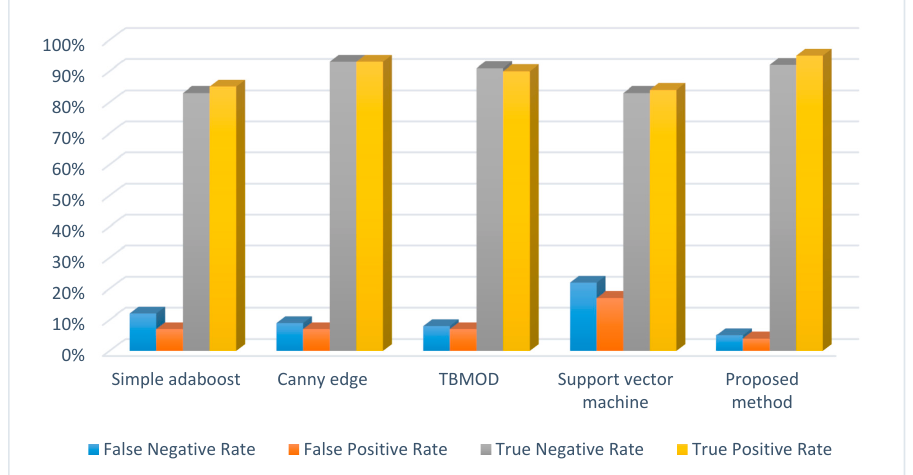
Figure 17. Detection success rate and comparison with other methods: Simple adaboost, Canny edge [7], TBMOD [8] and Support vector machine [15].